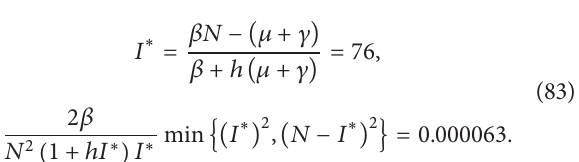
3.2083, 3.3283, and 3.3321, respectively, and all of them are bigger than 1.